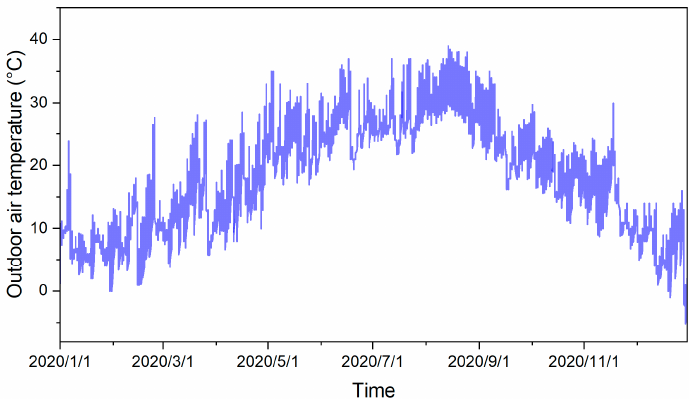
Figure 2. Changes in outdoor air temperature in Hangzhou in 2020.